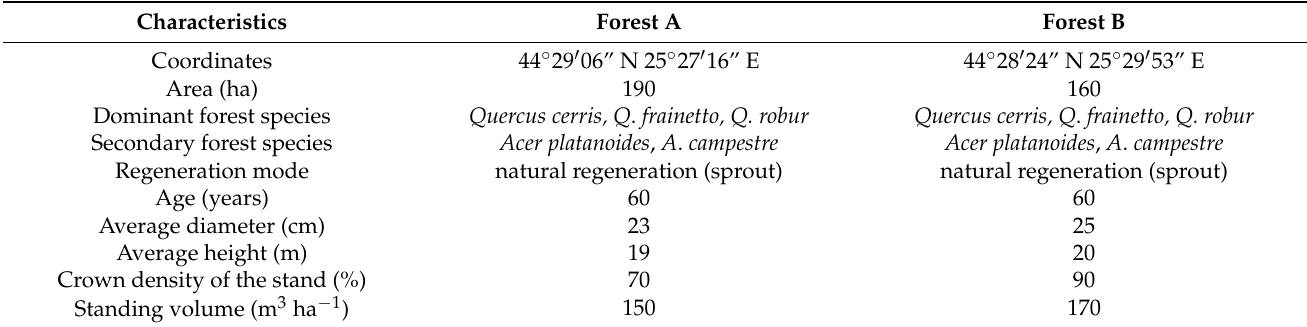
Figure 1. Location of the study area (Esri, Maxar, GeoEye, Earthstar Geographics, CNES/Airbus DS, USDA, USGS, Aero Grid, IGN, and the GIS User Community). Table 1. Description of the two experimental forests.